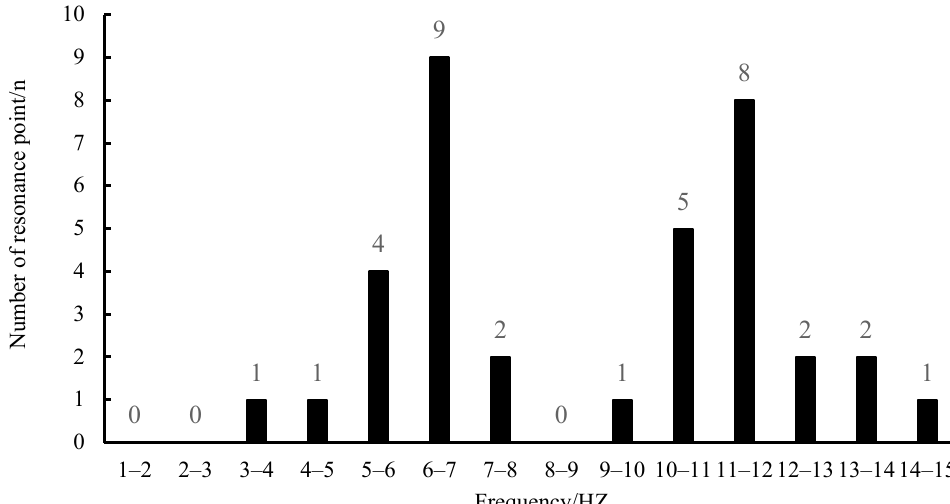
Figure 7. Frequency distribution range corresponding to the vibration peak point of the rape plant.